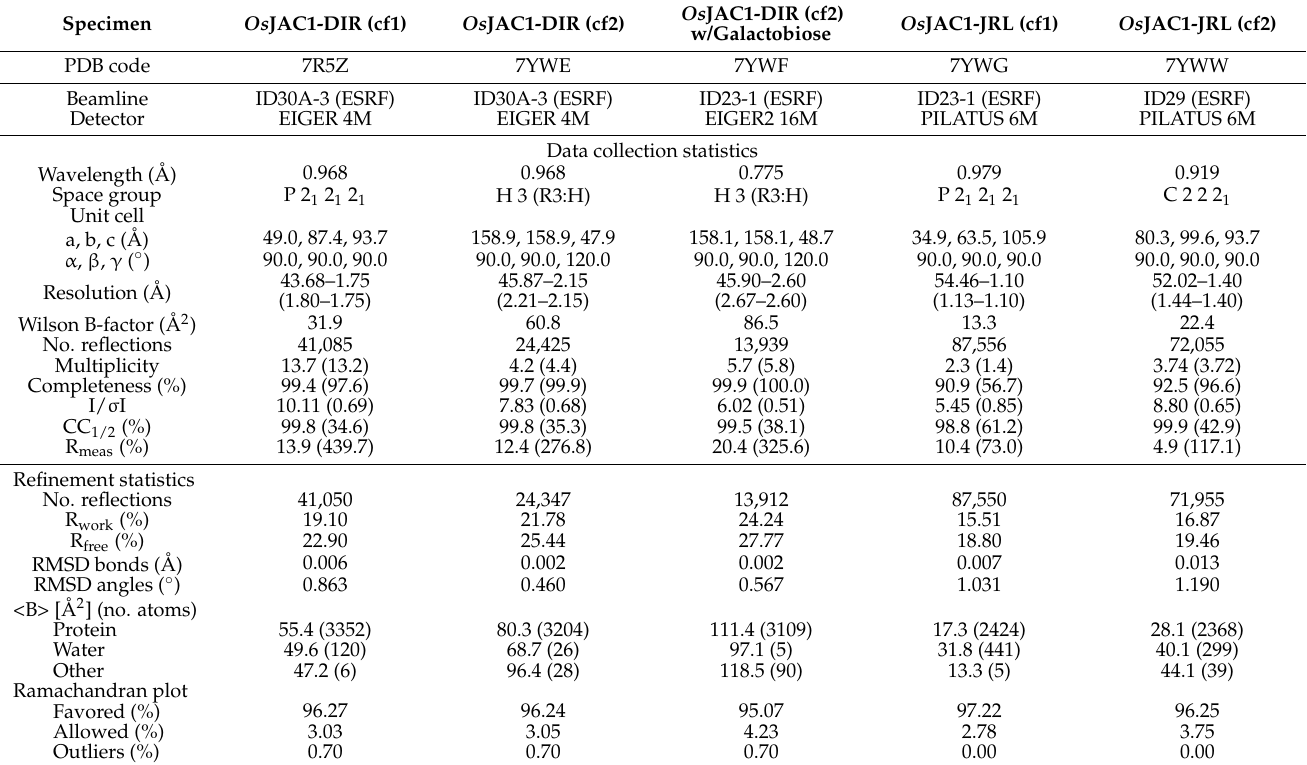
Table 2. Data collection and refinement statistics for the Os JAC1 structures discussed in this